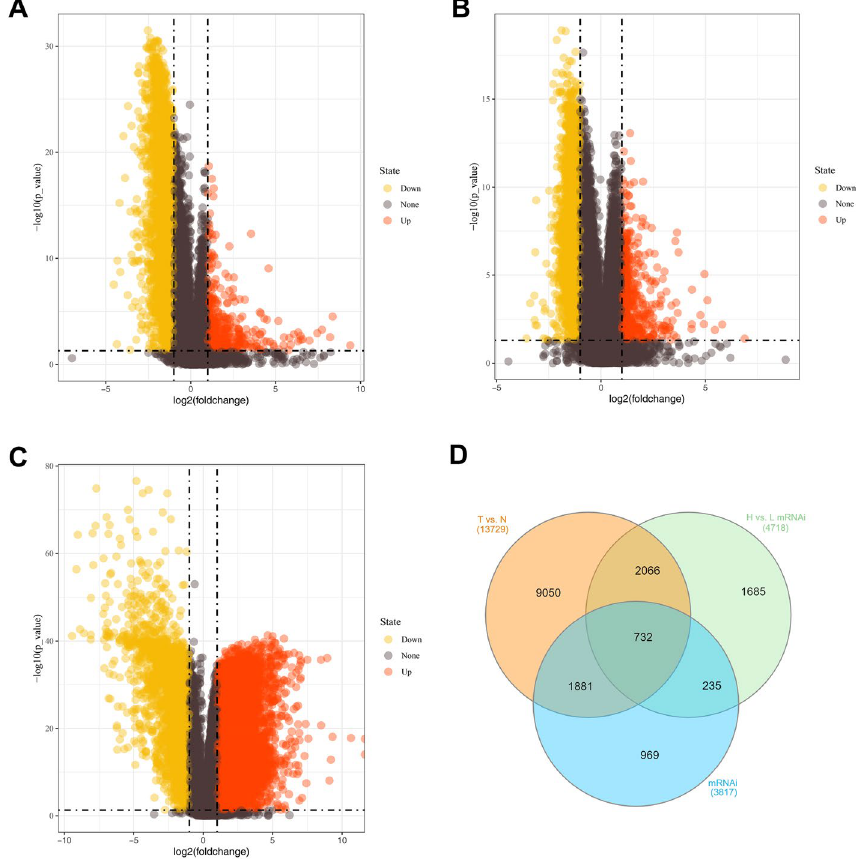
Figure 1. Identification of stemness indices-related DEGs. Notes: Volcano plots for DEGs in high-mRNAsi and low-mRNAsi ccRCC samples from ( A ), high-EREG-mRNAsi and low-EREG-mRNAsi ccRCC samples from ( B ), and tumor and normal tissues ( C ). ( D ) Venn diagram for DEGs from 3 different data sets. DEGs: differentially expressed genes; ccRCC: clear cell renal cell